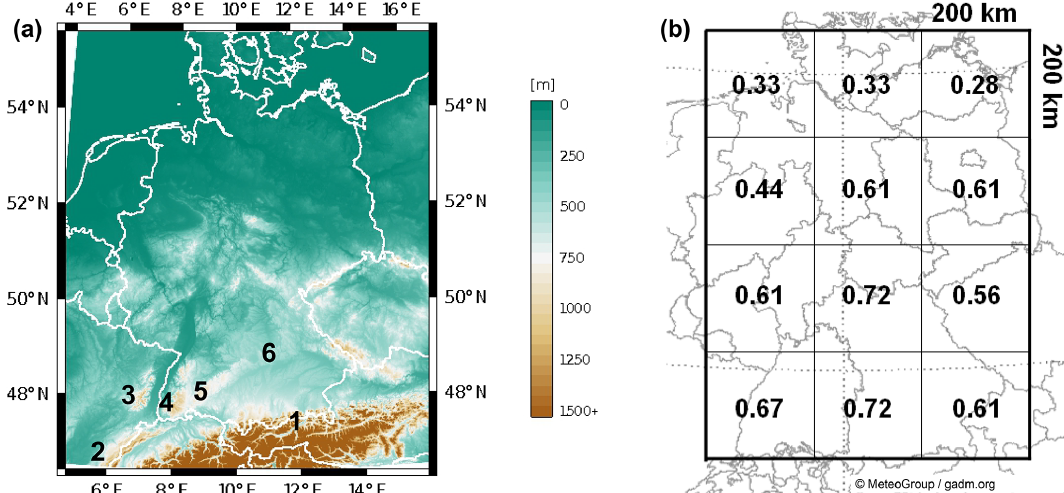
Figure 1. (a) Topography of Germany. Terrain height (m) is given by shading according to the color bar. Mountains mentioned in the text are highlighted by numbers: 1 – Alps, 2 – Swiss Jura, 3 – Vosges, 4 – Black Forest, 5 – Swabian Jura, 6 – Franconian Jura. (b) The number of moderate- and high-end-intensity derechos affecting grid boxes with 200km side length across Germany per year (1997–2014).